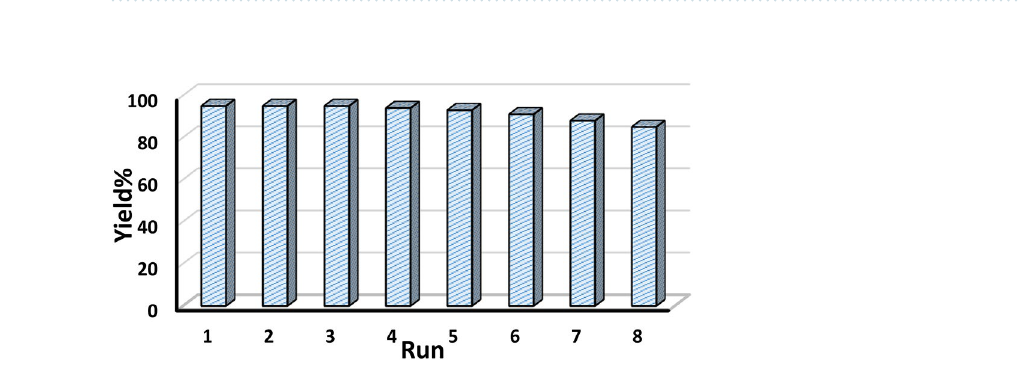
Figure 10. Reusable nature of the